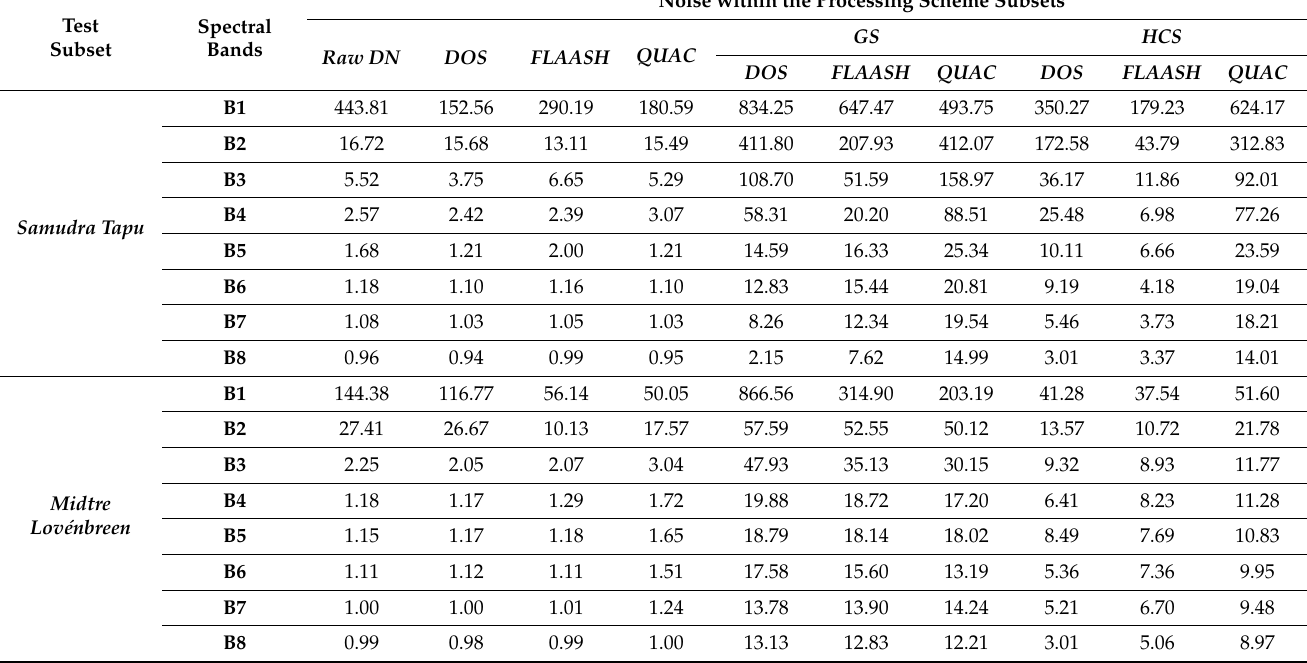
Table 12. Eigenvalues of noise contained in the VHR WorldView-2 data of the test sites. Noise was computed for the raw data and each processing scheme for two selected glacial subsets. Noise was calculated following the MNF operation in